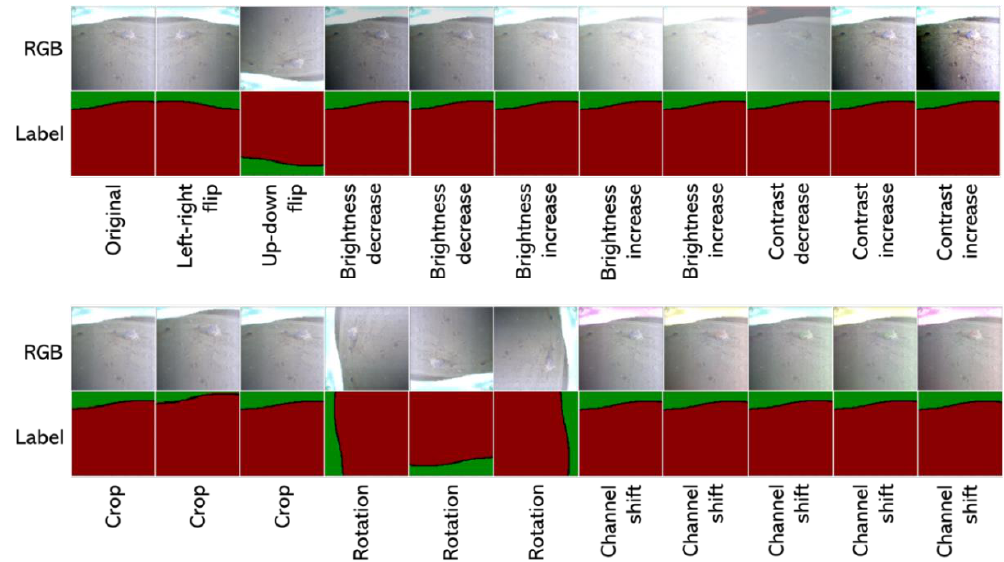
Figure A4. The augmentation schemes. RGB refers to the image data with red, green, and blue channels, and label refers to the corresponding augmented label-images. The original RGB refers to the original image, and the original label refers to the corresponding annotation of the original RGB image. The annotation process parallelly for both original RGB and label. For example, the “Left-right flip” conducts horizontal flip to both original RGB and label. The “Up-down flip” conducts vertical flip to both original RGB and label. Other parameters include brightness, contrast, and the order of color channels. The “crop” refers to crop a part of the image and resize it to the original size.